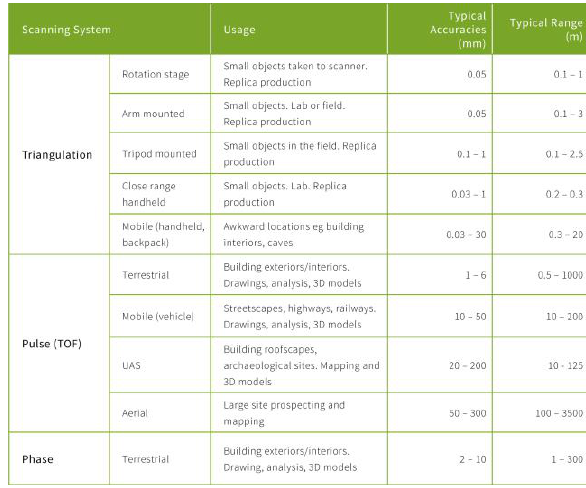
Table 1: Laser scanning systems and their uses. (Historic England,